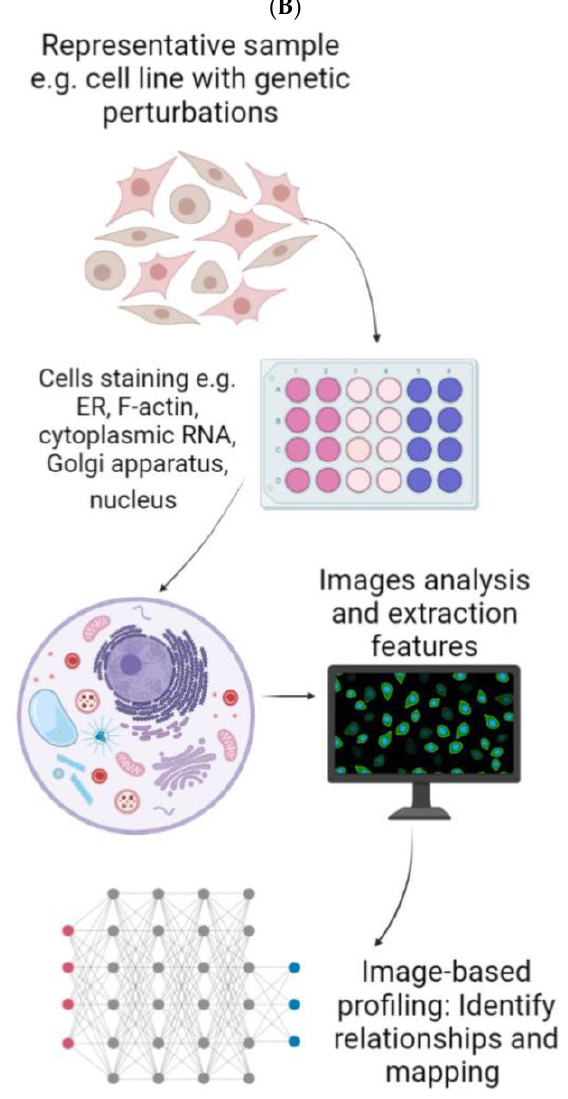
Figure 5. Potential pipeline for the discovery of host-targeted antivirals. ( A ) Workflow to search for cellular targets involved in virus–cell interactions. Databases provide initial identification of possible targets in the interactions between viruses and cells that need to be confirmed by experimental techniques. The next step includes repositioning existing drugs or discovering new inhibitors that may act as host-targeted antivirals. ( B ) Image-based profiling overview from biological samples.